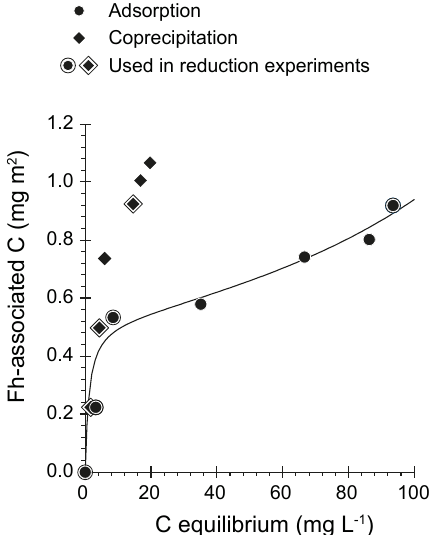
Figure 3. Ferrihydrite-associated C (normalized to the specific sur- face area of 197m 2 g − 1 of the control ferrihydrite) vs. C in the equi- librium solution. The line represents a BET